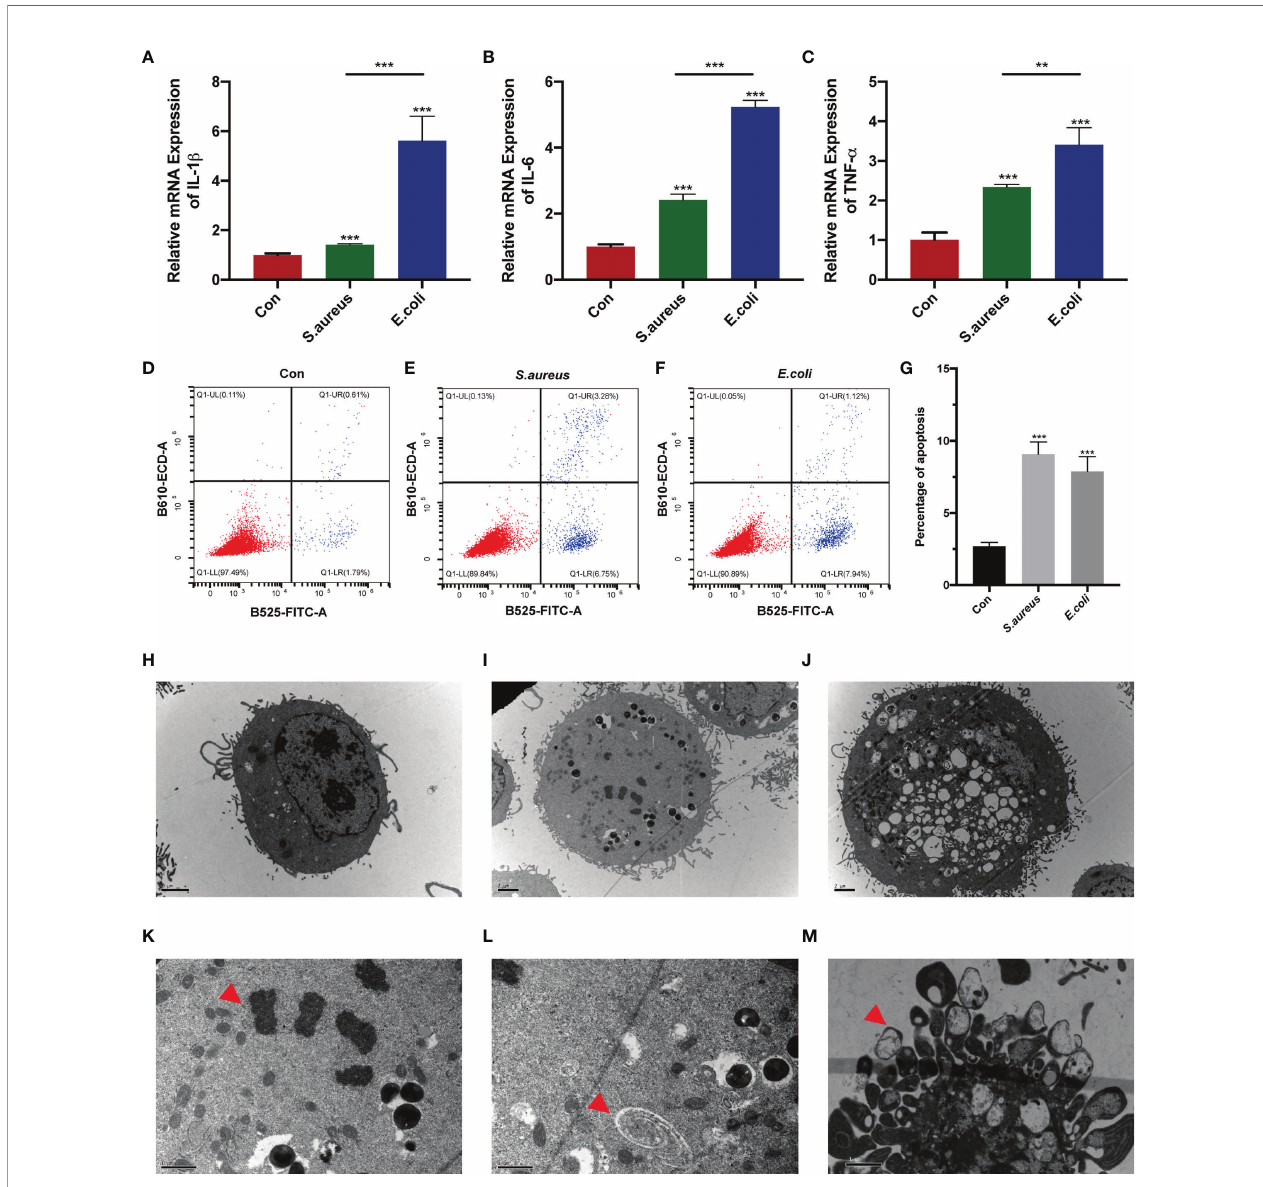
FIGURE 1 | MAC-T cells injured by S. aureus and E. coli . (A – C) MAC-T cells were stimulated by inactivated S. aureus and E. coli and signi fi cantly higher IL-1 b , IL-6, and TNF- a mRNA expression was found in the treatment groups. (D – F) Flow cytometry detected apoptosis in the S. aureus group and E. coli group. (G) The percentage of apoptotic cells in the S. aureus group and E. coli group was signi fi cantly higher than that in the control group. (H – M) Transmission electron microscopy (TEM) imaging of MAC-T cells. TEM illustrated (H) normal MAC-T cells, (I) MAC-T cells injured by S. aureus , and (J) MAC-T cells injured by E. coli . (K) Nuclear membrane disappearance, chromatin condensation (red arrow) and (L) autophagosomes (red arrow) were found in the S. aureus group. (M) Apoptotic bodies (red arrow) were found in the E. coli group (** p < 0.01, *** p <